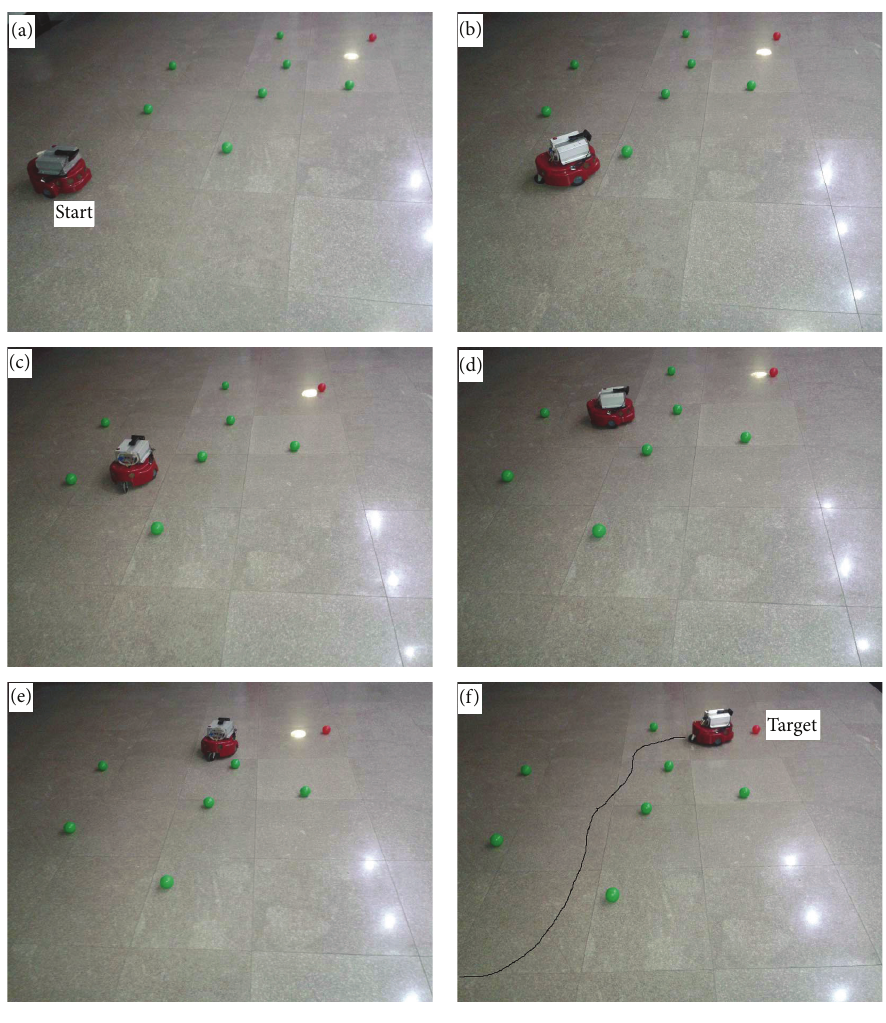
Figure 10: Complex